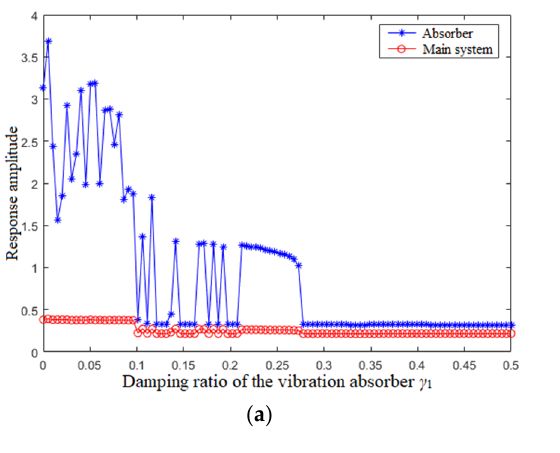
Figure 18. Response amplitude and phase diagram of two vibrators in the case of off-resonance ω = 0.6. ( a ) Response amplitude; ( b ) Phase diagram ( γ 1 = 0.01).